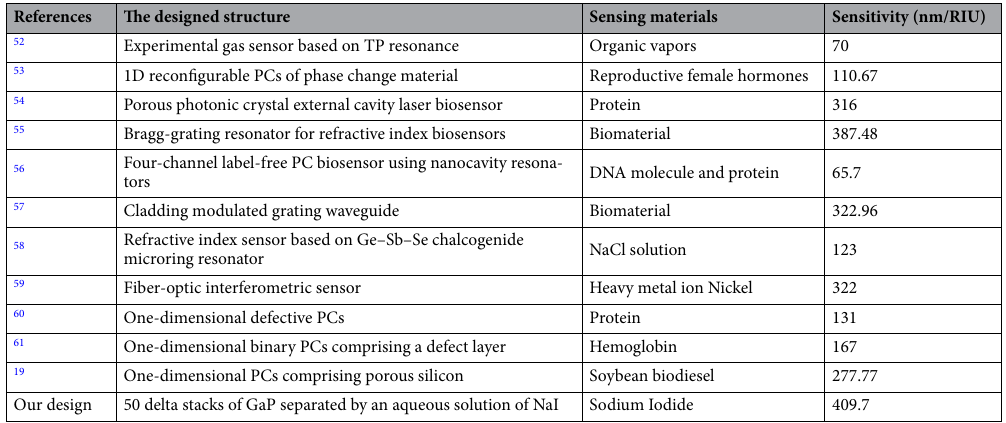
Table 1. The performance of the proposed sensor in the vicinity of sensitivity versus some optical and photonic